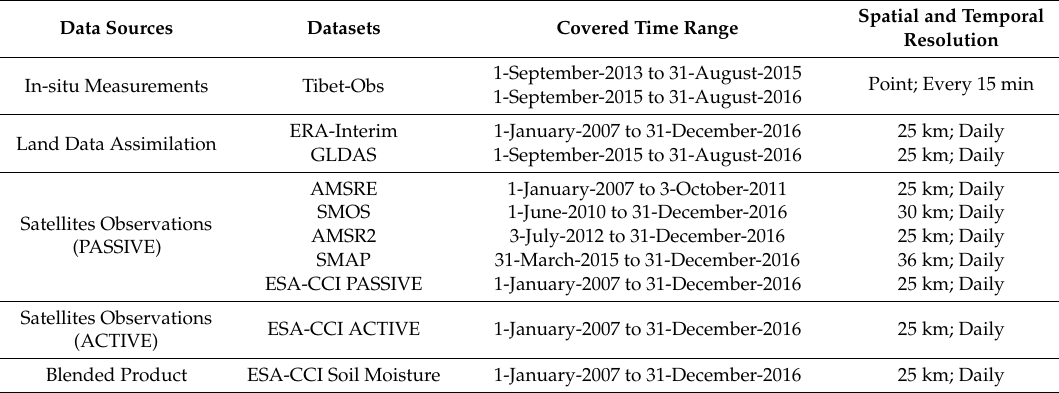
Table 1. Start-End Dates Diagram of all the Data Sets for Data Processing.